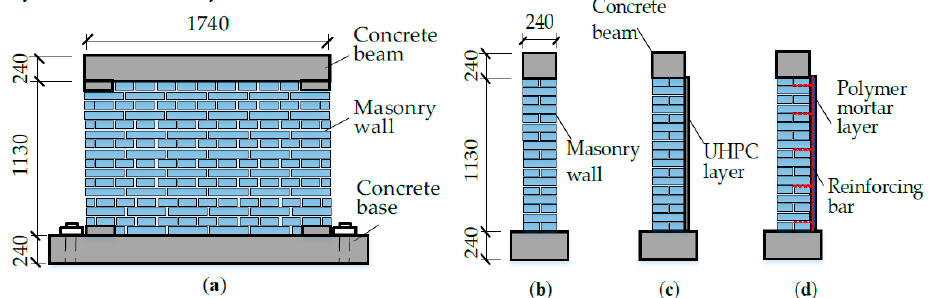
Figure 2. Profile of the historical wall specimens: ( a ) Front view; ( b ) right view of W1; ( c ) right view of W2 and W1S; ( d ) right view of W3.